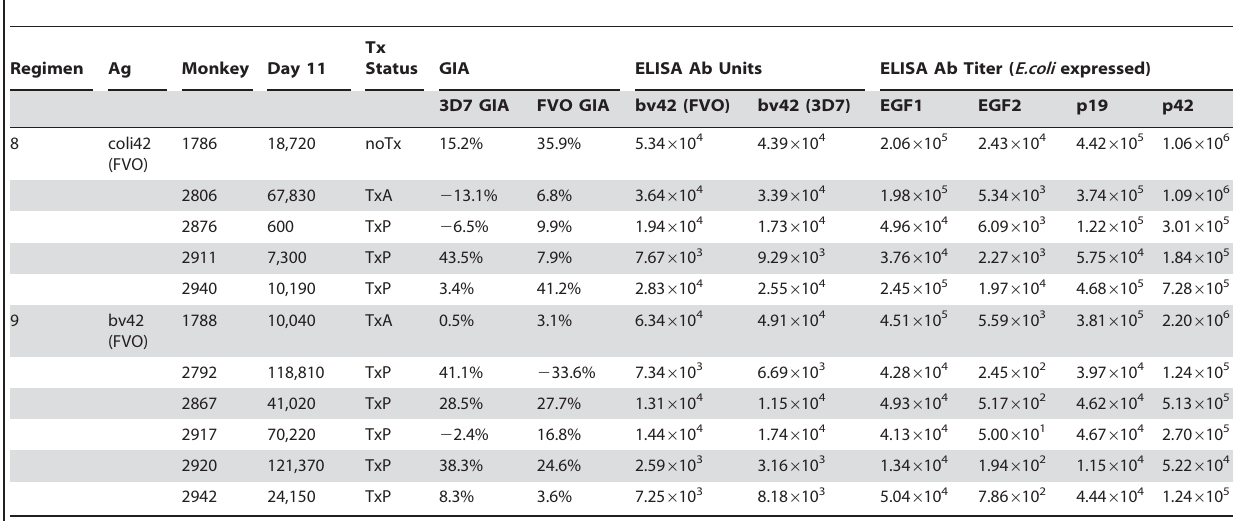
Table 3. Trial Design and Results for Adjuvant Montanide ISA-720